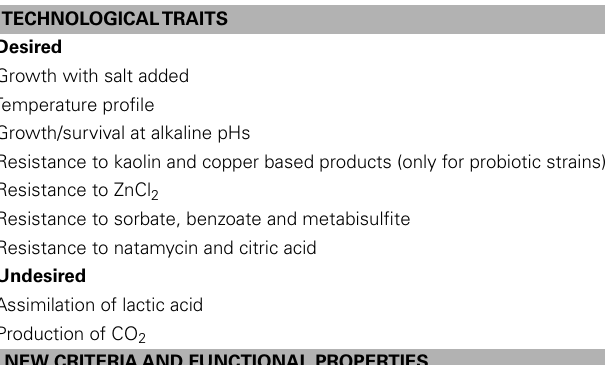
Table 2 |Technological and functional properties of yeasts for table